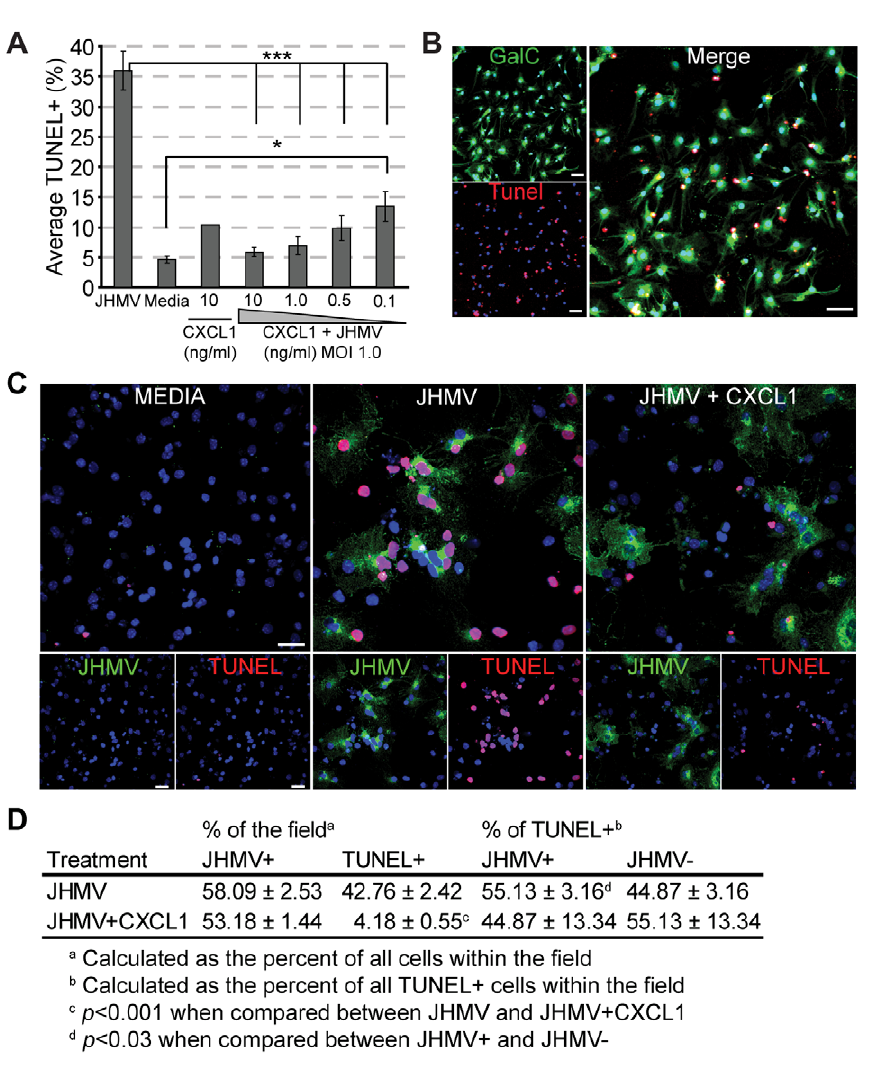
Figure 7. The CXCR2 ligand CXCL1 protects oligodendrocytes from JHMV – mediated apoptosis invitro . Differentiated oligodendrocyte enriched cultures were infected with JHMV (moi 1.0), treated with varying concentrations of recombinant mouse CXCL1, and assessed for apoptosis